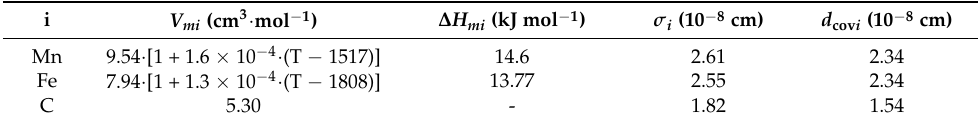
Table 1. Input parameters of the three elements in the MIVM.